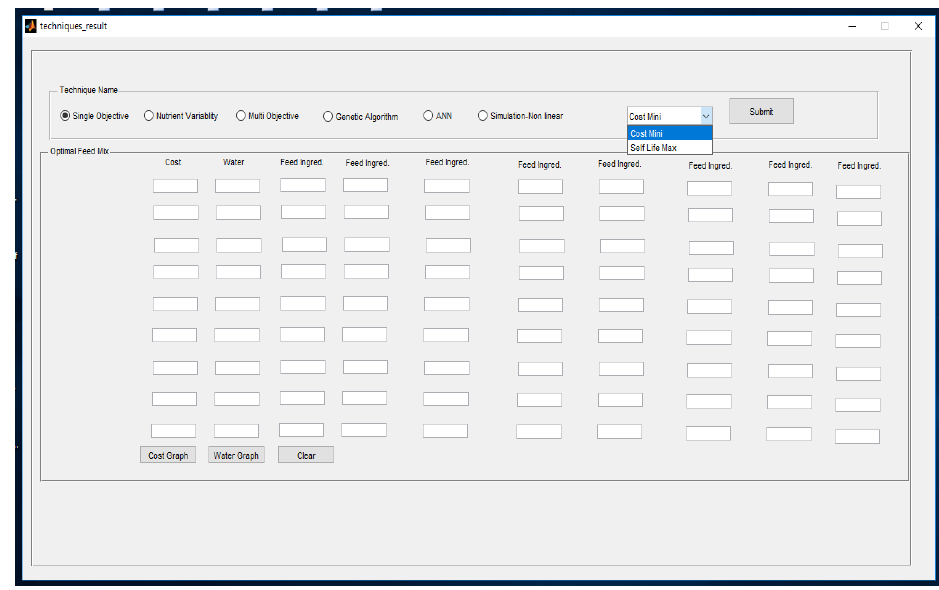
Figure 4. Selection of technique by the